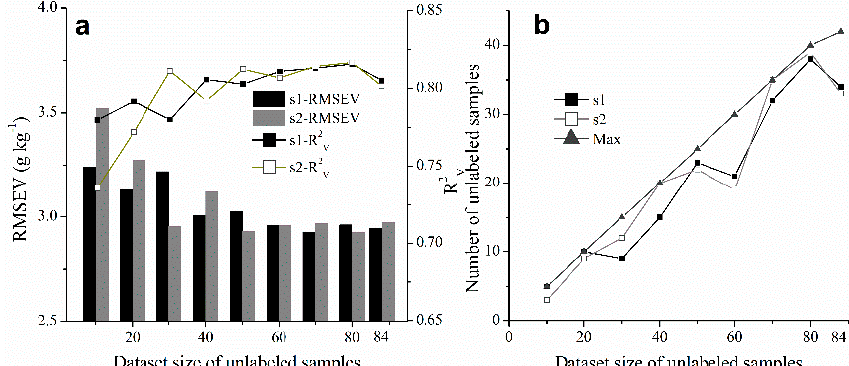
Figure 12. The performance of the two refined models of: Co-LSSVMR ( a ); and the number of unlabeled samples used in each refined model ( b ) versus the pool size of unlabeled samples with 80 labeled samples used in calibration. “Max” in ( b ) indicates the maximum number of unlabeled samples available for each regressor.